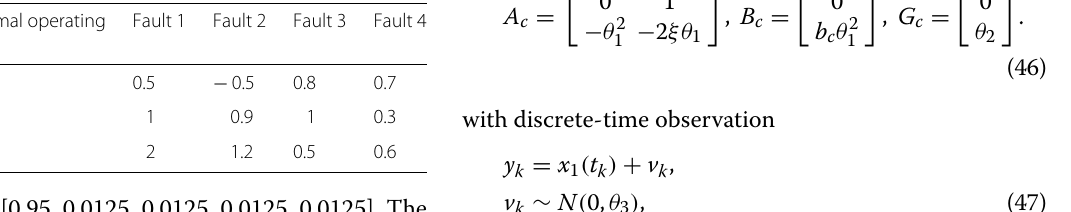
Table 1 Parameters of system (45) dependent on normal and faulty conditions